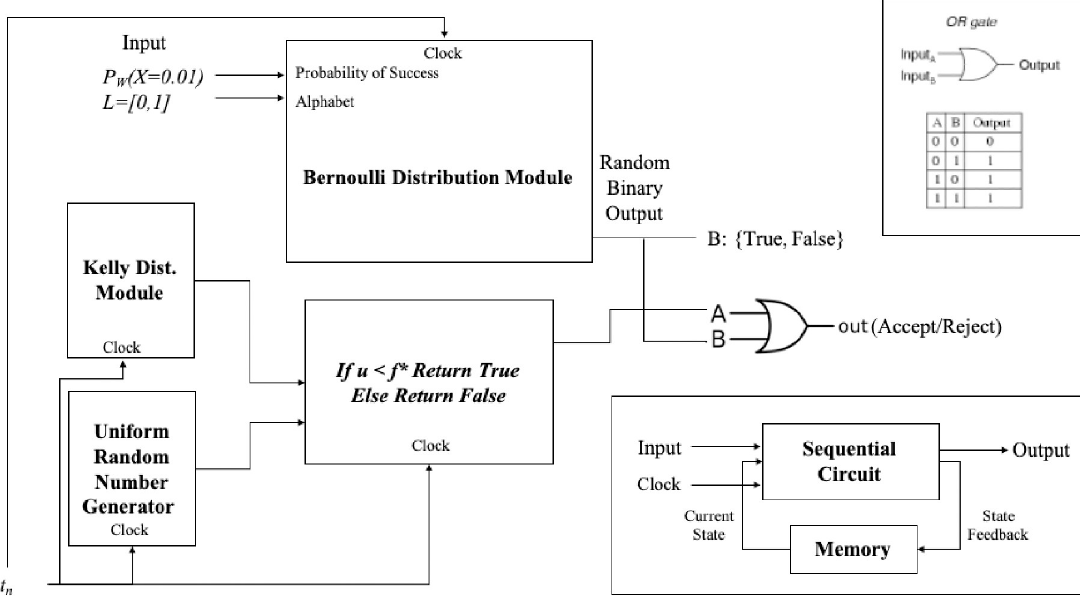
Fig 23. Decision Criterion 2 is implemented as a OR gate using the input bernoulli distribution Trial B and The output A of the IF statement from the Simulated Kelly Criterion and the uniform random number output value.